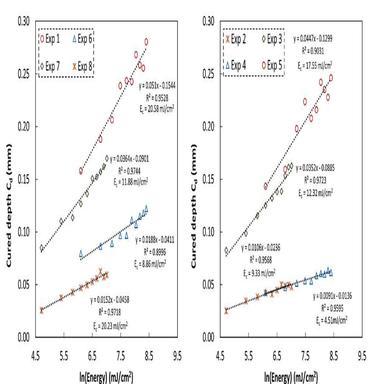
Main effects plots representing mean of depth of penetration (Dp).